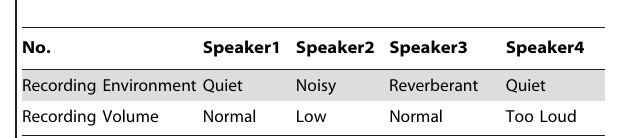
Table 3. Recording Condition